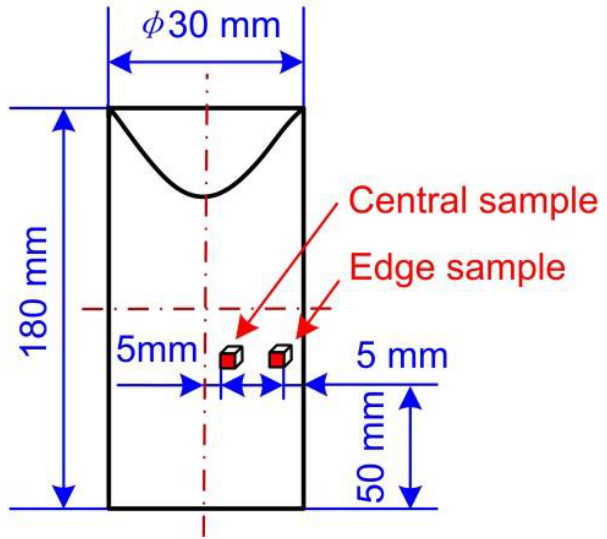
Figure 6. Schematic of the sampling positions.